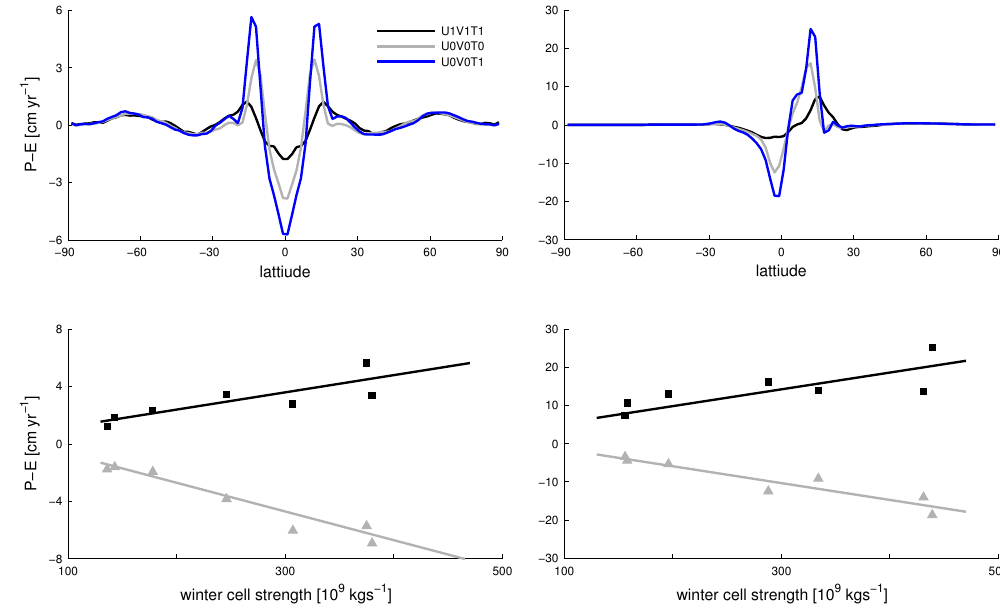
Fig. 10. Top panel: tropical pattern of precipitation minus evaporation ( P − E ) for simulations with seasonally varying insolation (left) and perpetual off-equatorial insolation (right) and different treatment of vertical diffusion of momentum. Bottom panel: peak values of the precipitation minus evaporation pattern versus strength of the winter cell. Triangles show the equatorial minimum, squares the maximum at around 10–15 ◦ latitude. The peak values scale linearly with the strength of the winter